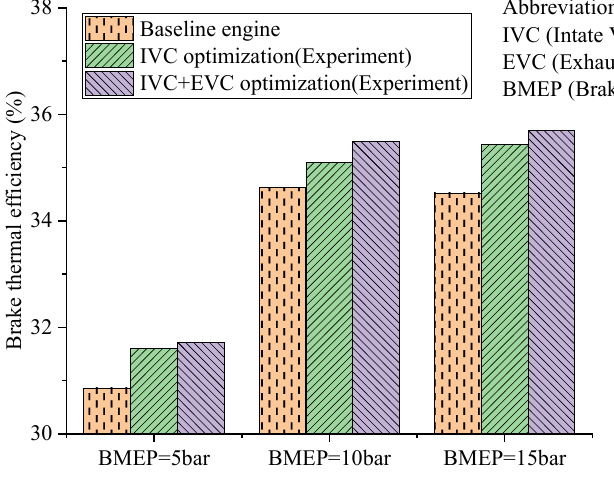
Figure 14. Comparison of brake thermal efficiency.